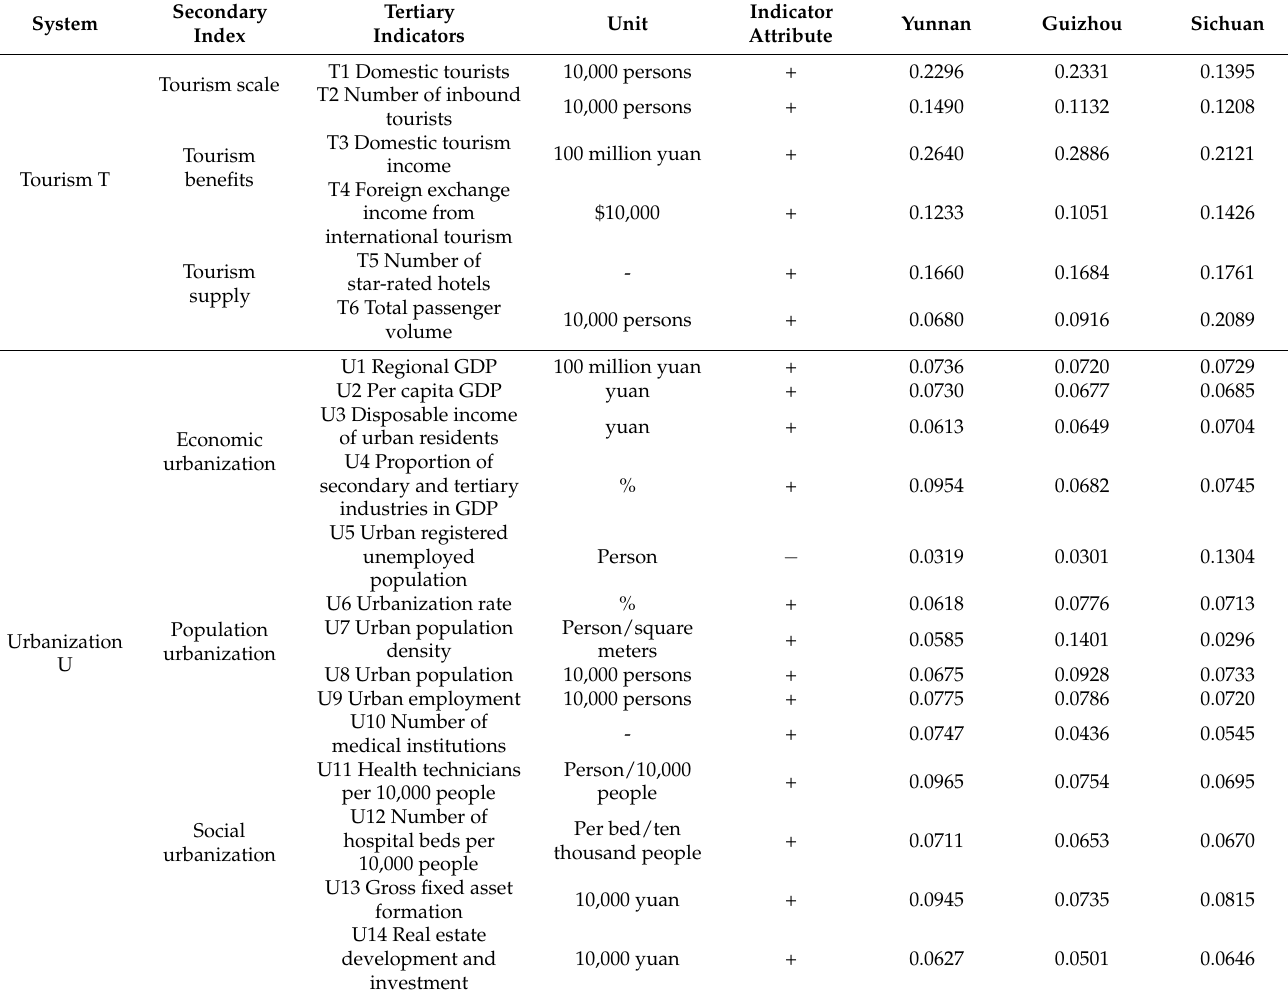
Table 2. Comprehensive evaluation indicators for the tourism, urbanization, technology, and ecologi- cal environment